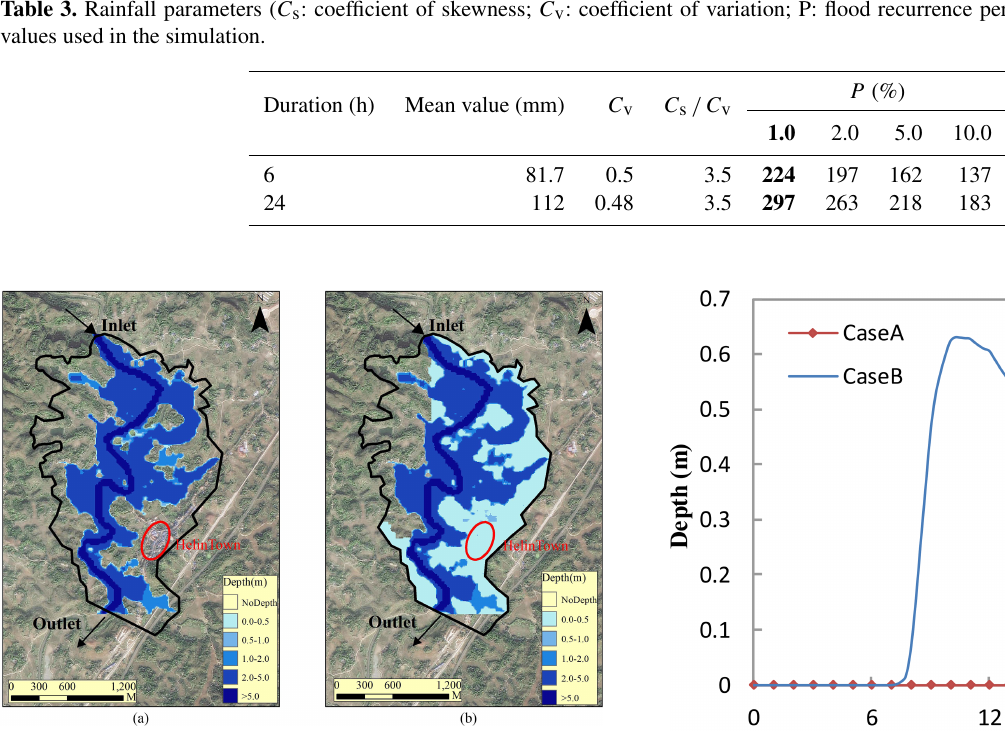
Figure 21. Comparison of maximum depth: (a) Case A and (b) Case B. The red circle denotes the location of Helin Town (satel- lite imagery base map was obtained from © Google Earth).